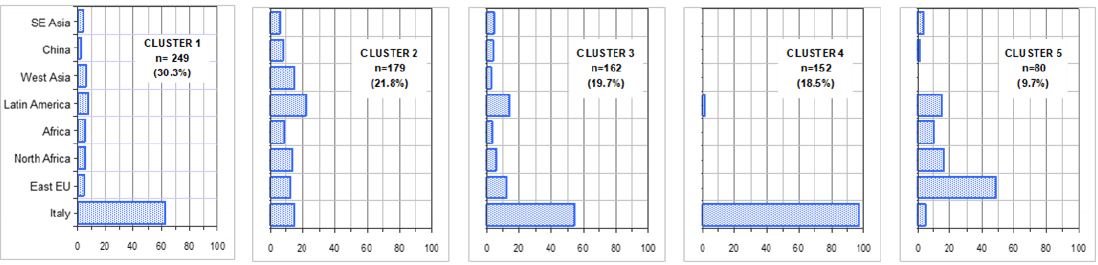
Figure 4. Distribution of the different ethnicities into the five clusters.